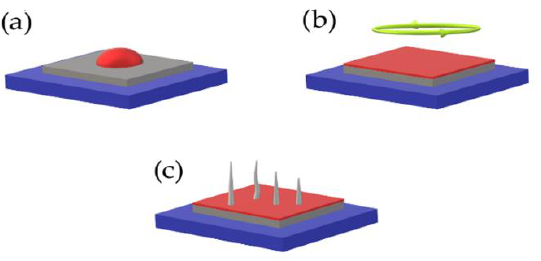
Figure 18. Sol gel process representation: ( a ) deposition of precursor material; ( b ) spin coating; ( c ) preheat and dry down.